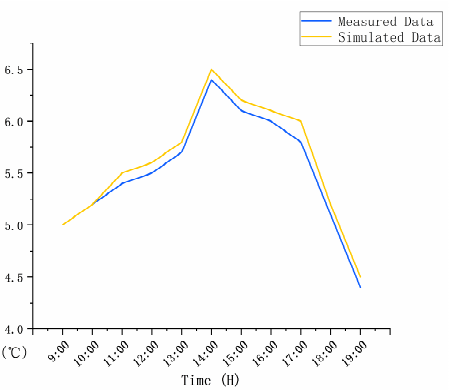
Figure 7. Comparison between the measured and simulated data.